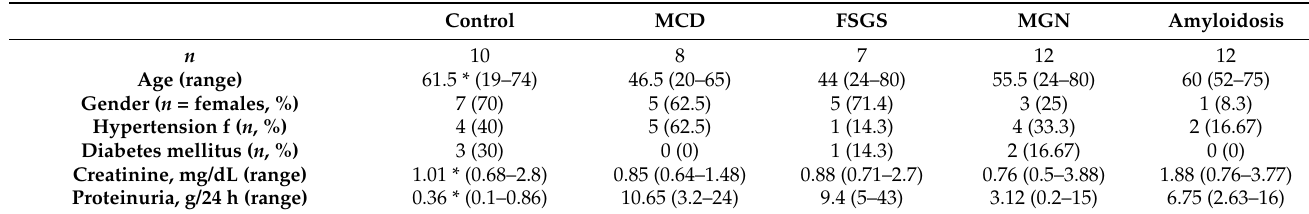
MCD—minimal change disease; FSGS—focal segmental glomerulosclerosis; MGN—membranous glomerulonephritis (primary and secondary). * Data are presented as median value (with range or percentage in brackets, as